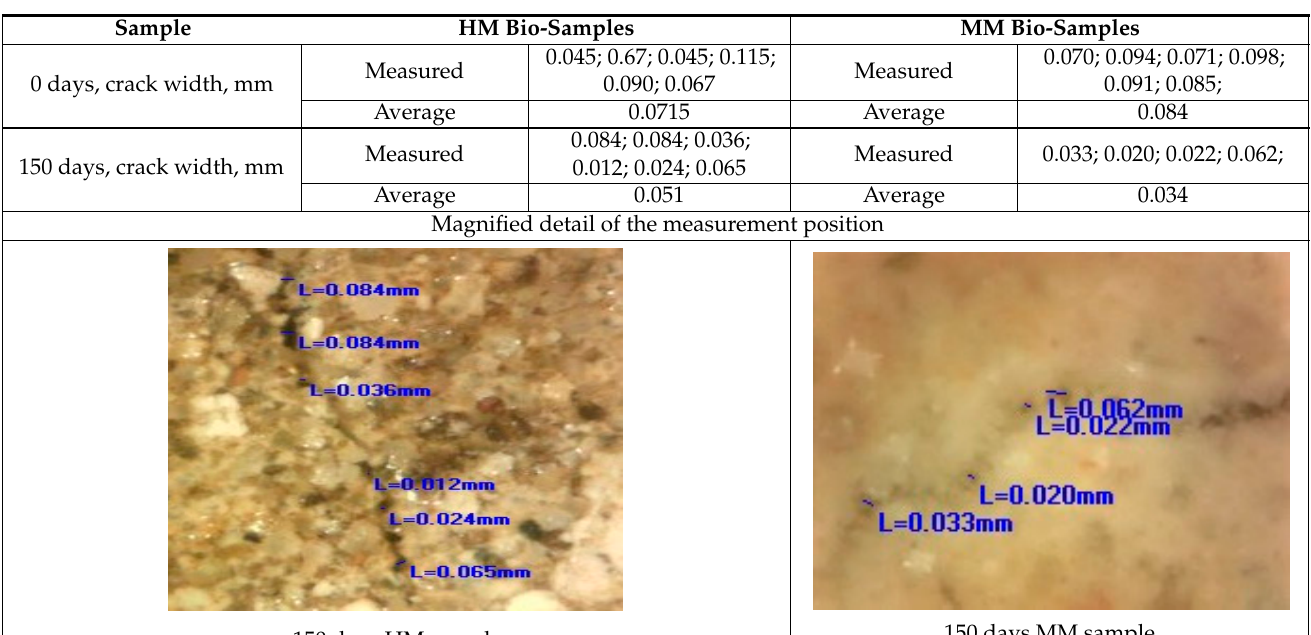
Table 5. Measured values of the crack width.